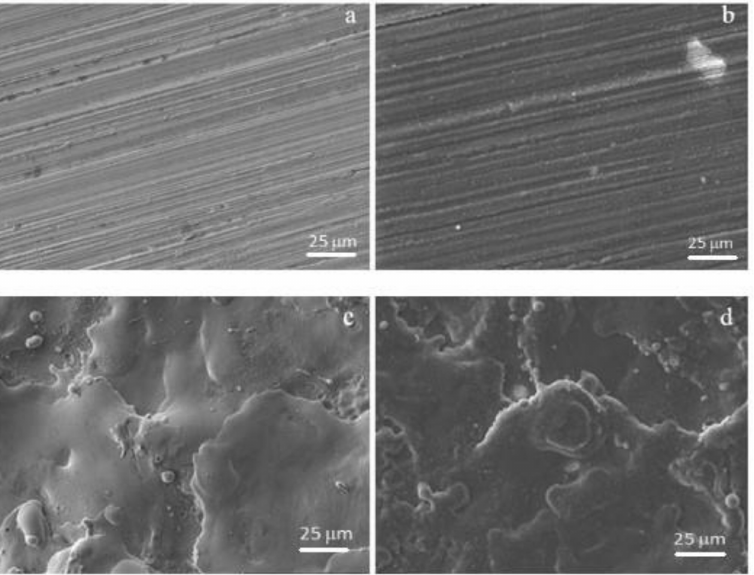
Figure 2. Secondary electron (SE) SEM images of the different surface conditions: ( a ) ground; ( b ) ground + DLC; ( c ) electric discharge texturing (EDT); and ( d ) EDT + DLC.